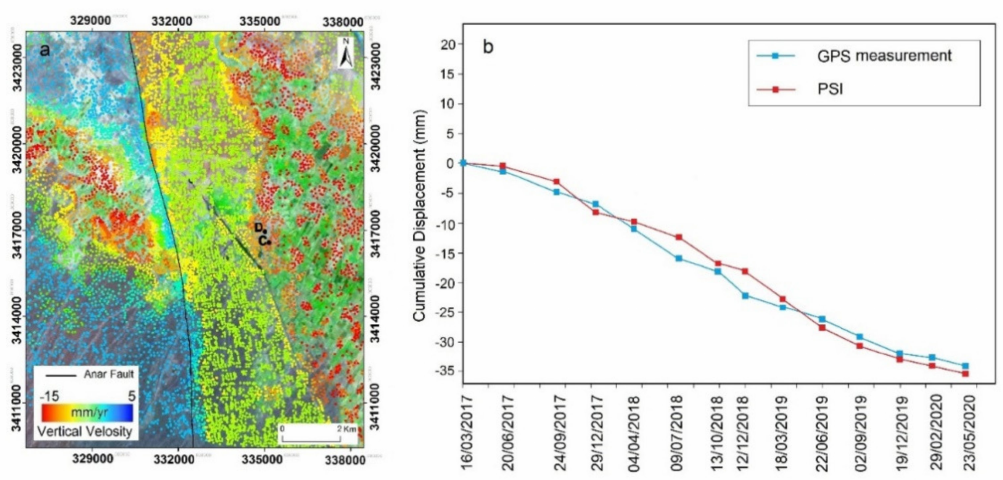
Figure 8. ( a ) Displacement measurement, ( b ) comparison between PSI results vs. GPS measurements on PS point C and GPS point D shown in ( a